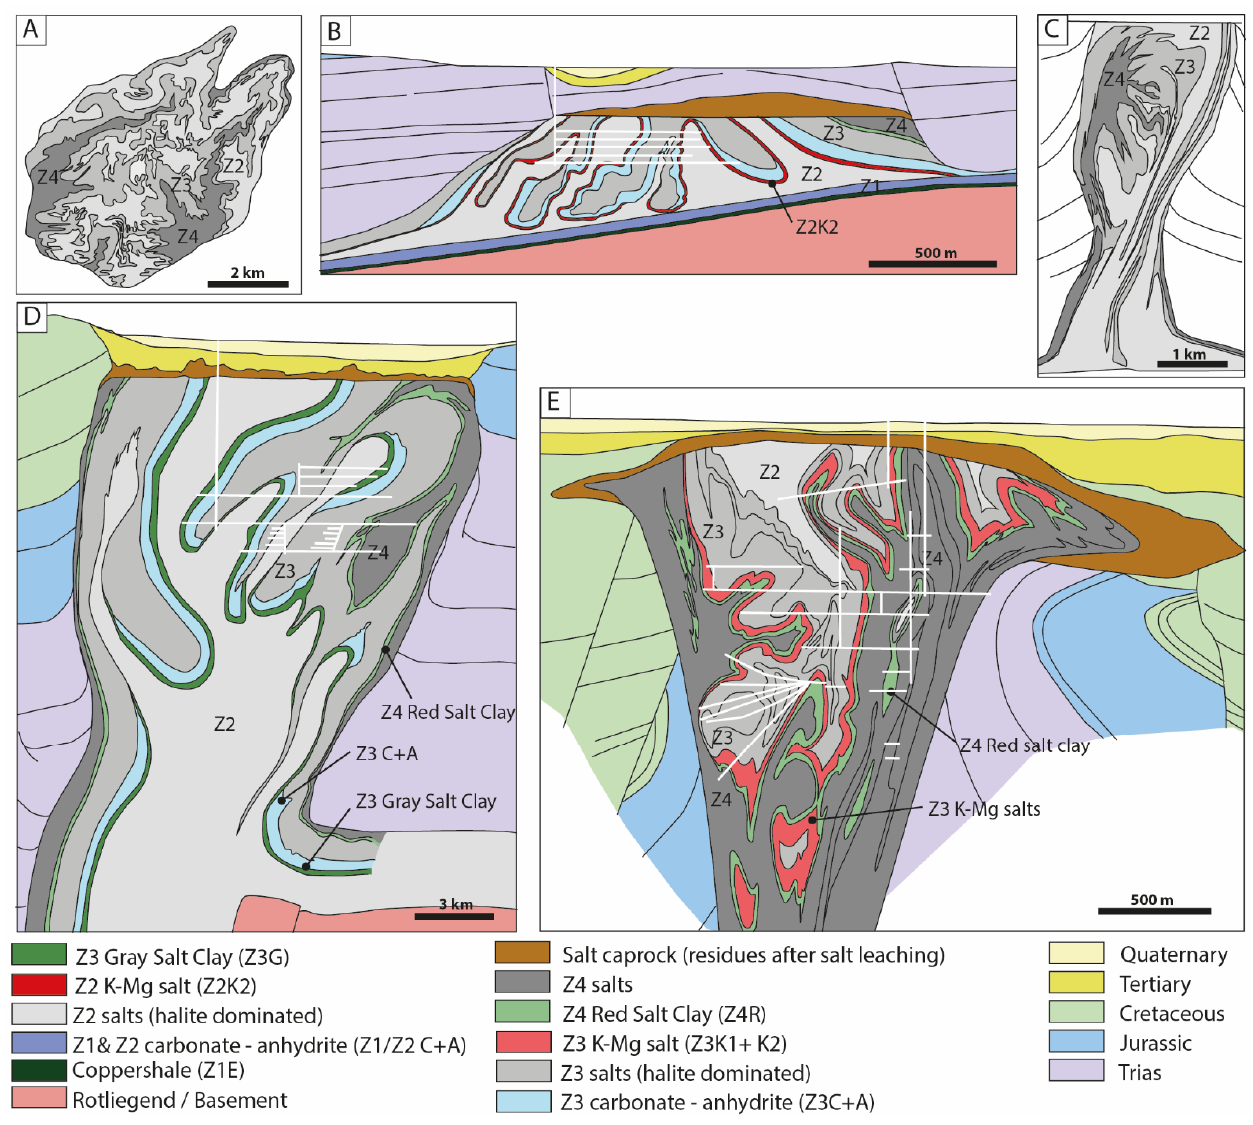
Figure 14. Illustration of very complex internal structures constrained by subsurface mine data in salt diapirs formed by the Zechstein salts in Germany. ( A ): Horizontal sections of the Sarstedt salt dome at a depth of 750 m below the surface (after [113]). ( B ): Cross section of the Bartensleben diapir (after [116]). ( C ): Cross section of a diapir hosting the Mariglück Mine (after [117]). ( D ): Cross section of a unnamed diapir (after [118]). ( E ): Cross section of the Hänigsen ‐ Wathlingen salt dome (after [119]).